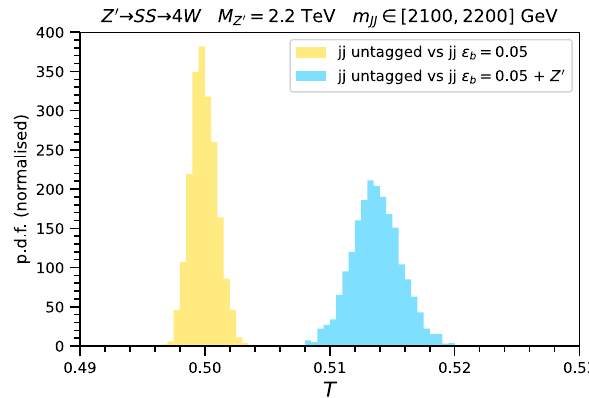
Fig. 10 Example of probability density functions for the estimator T , obtained from the comparison of untagged and tagged background events (yellow) or the same, with a signal injected